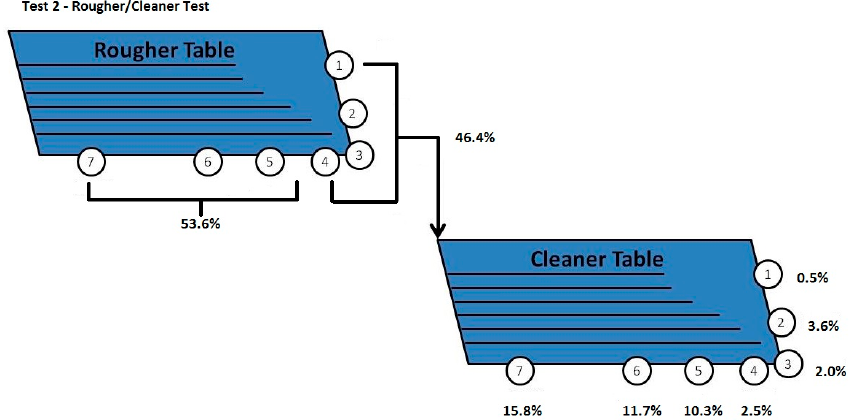
Figure 1. Experimental procedure and mass flow rates for audit testing using Penouta material.